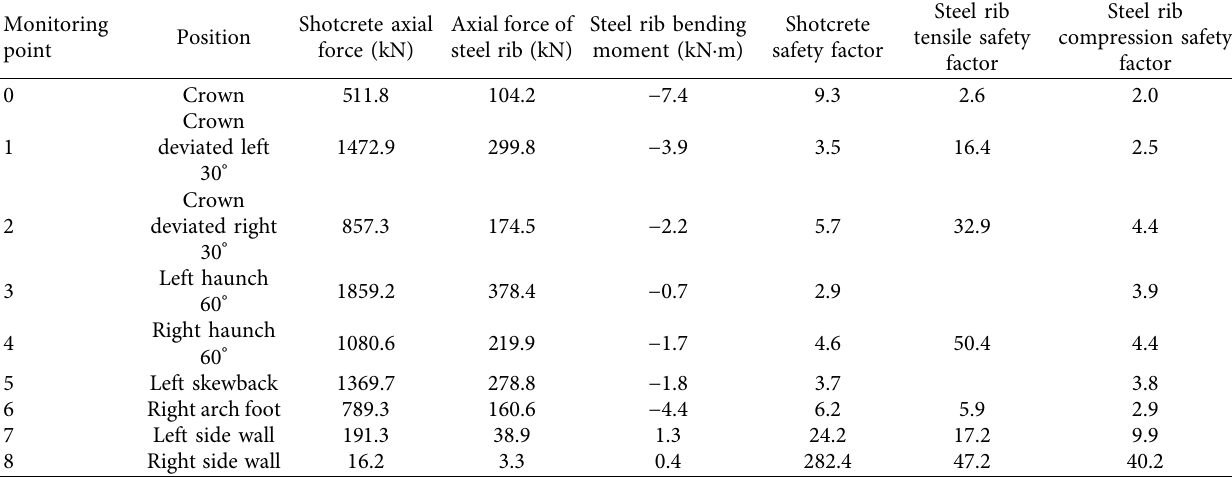
Table 8: Internal force and safety factor of primary support under parameter 1.